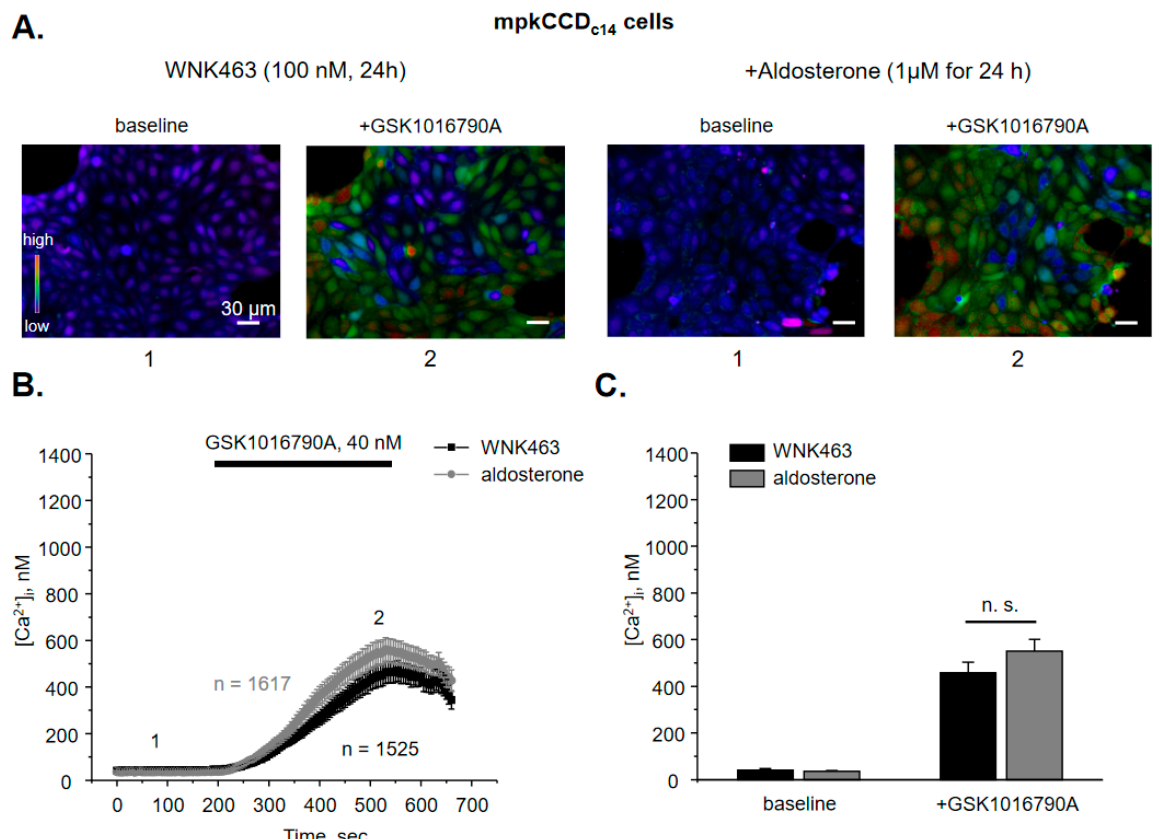
Figure 3. Inhibition of WNK signaling cascade precludes stimulation of TRPV4 activity by aldosterone in mpkCCD c14 cells. ( A ) Representative pseudo-color images of [Ca 2+ ] i changes (blue—low and red—high) at the baseline (1) and following 5 min application of TRPV4 agonist, GSK1016790A (2) in confluent monolayers of mpkCCD c14 cells treated with pan-specific WNK inhibitor WNK463 (100 nM) in the absence and presence of concomitant administration of aldosterone. ( B ) The averaged time-courses of [Ca 2+ ] i changes in individual WNK463 pretreated mpkCCD c14 cells in the absence and presence of aldosterone upon application of 40 nM GSK1016790A (shown with the bar on top). The time-points 1 (baseline) and 2 (GSK1016790A) represent conditions shown in panel (A). ( C ) Summary graph comparing [Ca 2+ ] i values in individual WNK463 pretreated mpkCCD c14 cells in the control and following aldosterone treatment at the baseline and after GSK1016790A application. N.s. represents non-significant difference ( p > 0.05).